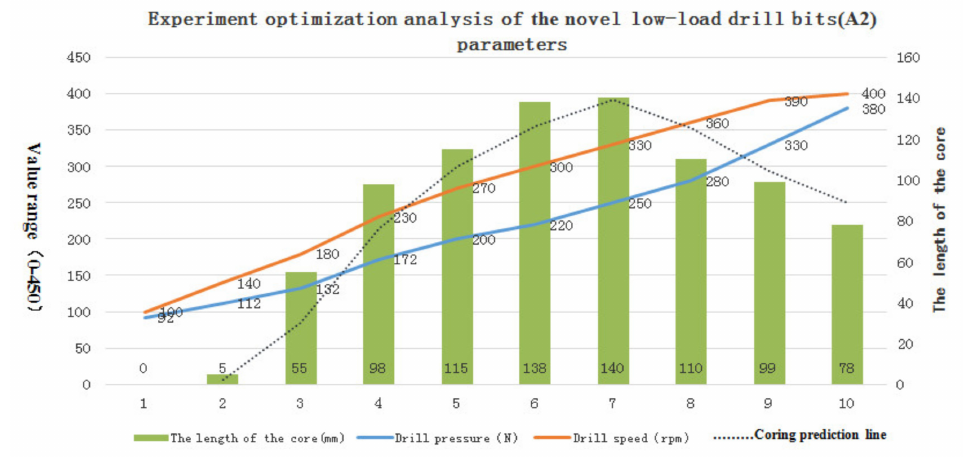
Figure 13. Double parameter tests of Rotary Speed and drilling pressure (A2 bit).